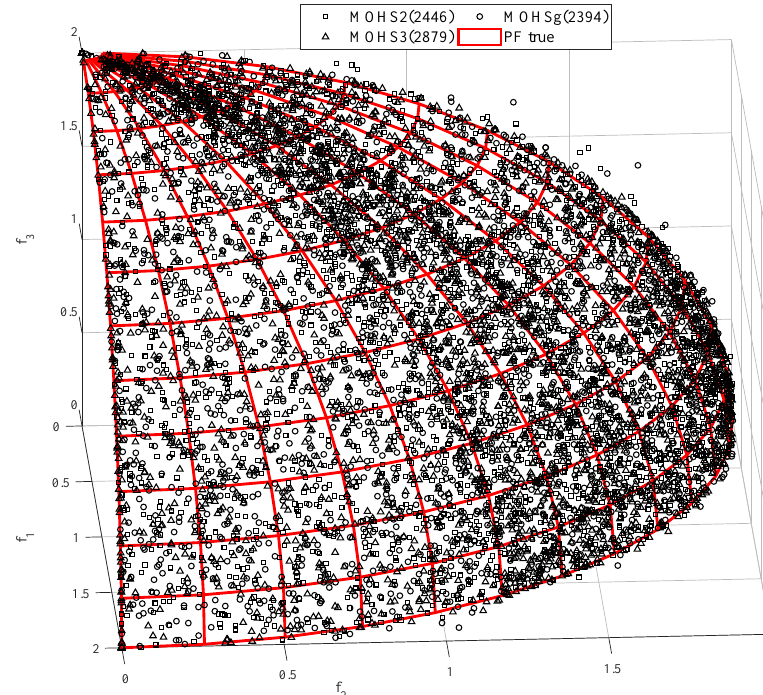
Figure 12. Pareto fronts for problem